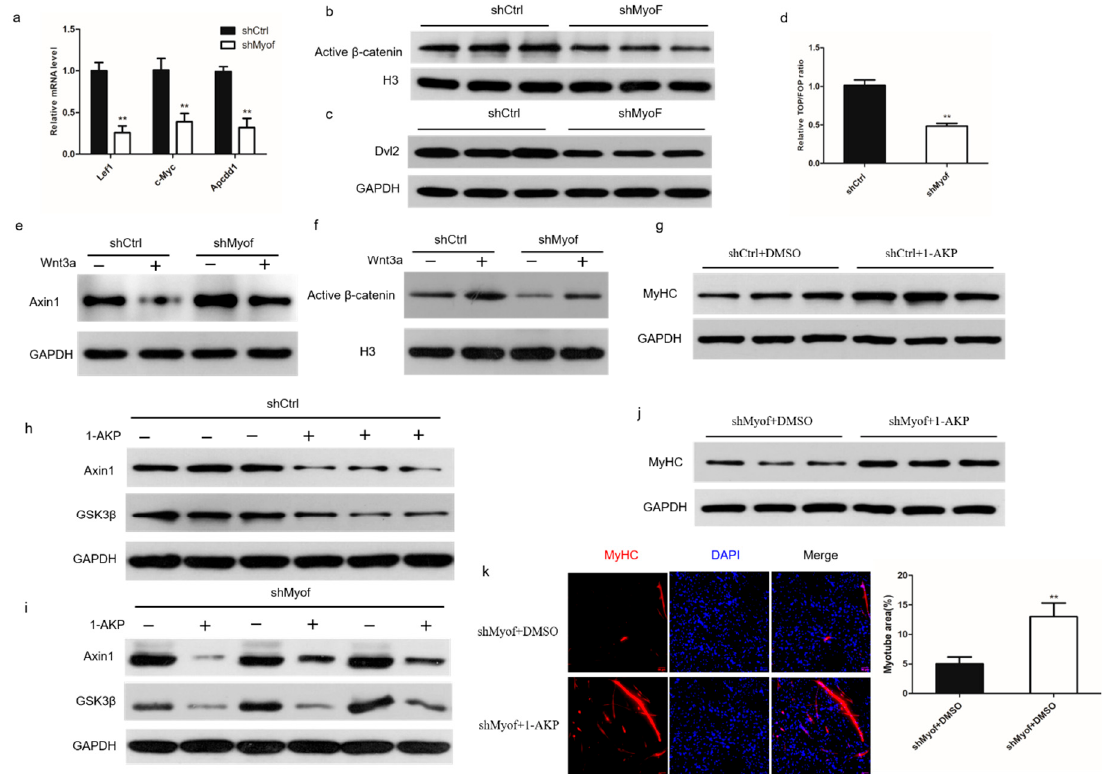
Figure 5. MyoF functions via Dvl-2-mediated canonical Wnt signaling. ( a ) qRT-PCR analysis of Wnt target gene (Lef1, c-Myc, and Apcdd1) expression in cells after transfection with shCtrl or shMyoF for 72 h. ( b ) Western blot analysis of β -catenin protein expression in nuclear lysates extracted from cells after transfection with shCtrl or shMyoF. ( c ) Western blot analysis of Dvl-2 protein expression. ( d ) TOP/FOP luciferase activity. ( e ) Western blot analysis of Axin1 protein levels after treatment with Wnt3a or saline for 24 h. ( f ) Western blot analysis of β -catenin protein levels in nuclear lysates extracted from cells after treatment with Wnt3a or saline for 24 h. ( g ) Western blot analysis of MyHC expression in shCtrl cells incubated with 1-AKP or DMSO for 72 h. ( h ) Western blot analysis of Axin1 and GSK3 β protein levels in shCtrl-transfected cells after incubation with 1-AKP for 72 h. ( i ) Western blot analysis of Axin1 and GSK3 β protein levels in shMyoF-transfected cells after incubation with 1-AKP for 72 h. ( j ) Western blot analysis of MyHC expression in shMyoF cells incubated with 1-AKP or DMSO for 72 h. ( k ) Immunofluorescence staining of MyHC in shMyoF cells incubated with 1-AKP or DMSO for 72 h, scale bars are 50 µ m. The bar graph on the right shows the myotube area (%). Data represent means ± SEM ( n = 3 independent cell cultures). * p < 0.05; ** p <